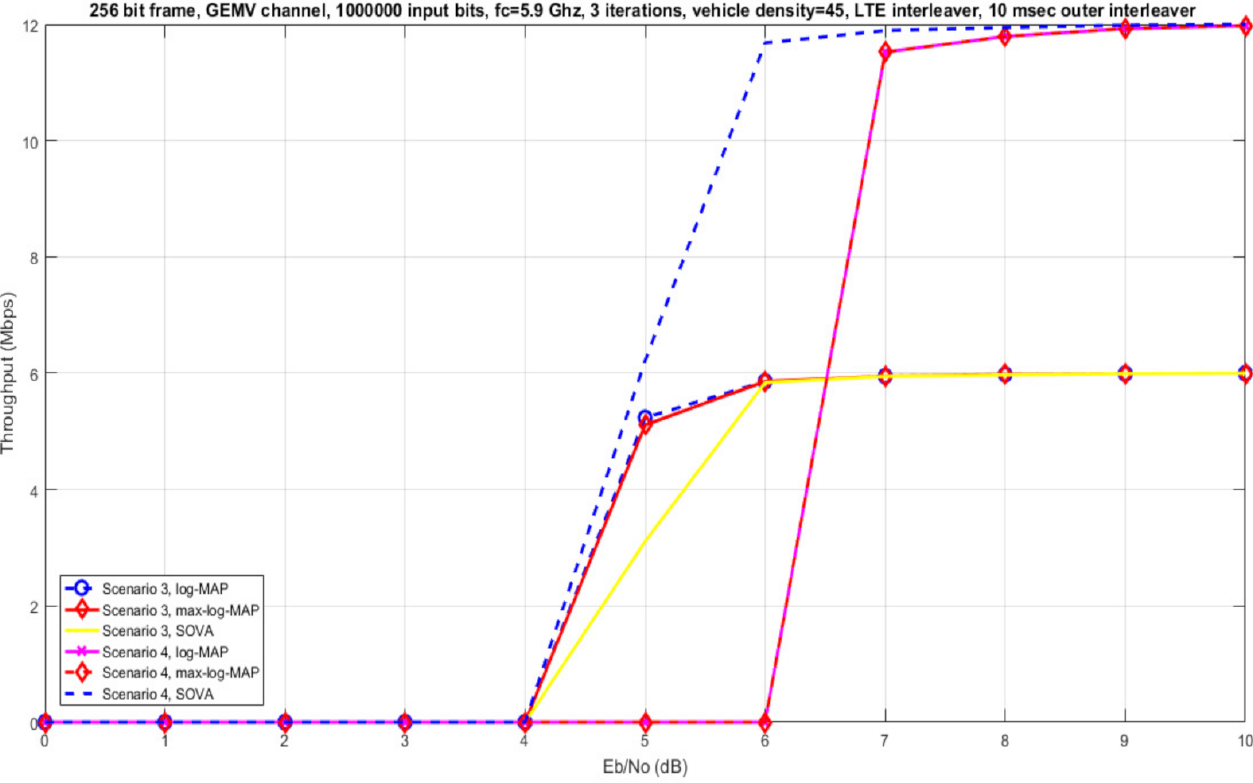
Figure 10. Throughput vs. SNR for scenarios 3 and 4 of Table 2, considering different decoding algorithms, 3 iterations, frame length of 256